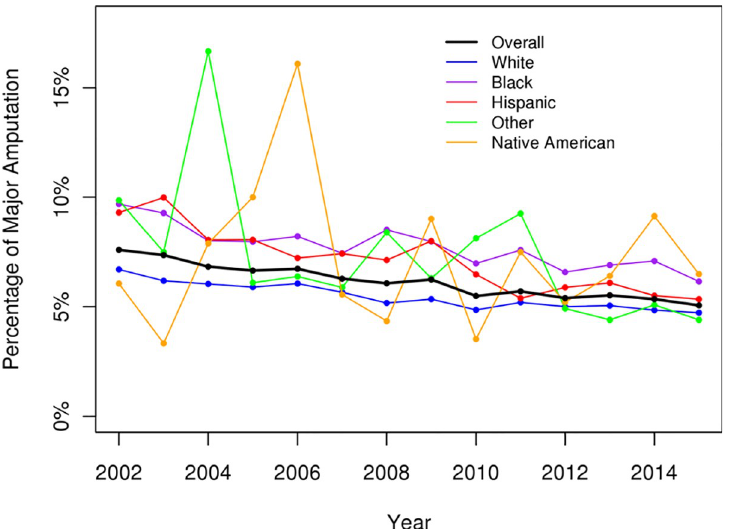
Fig 2. Percentage of major amputations for diabetic foot infections (overall p <